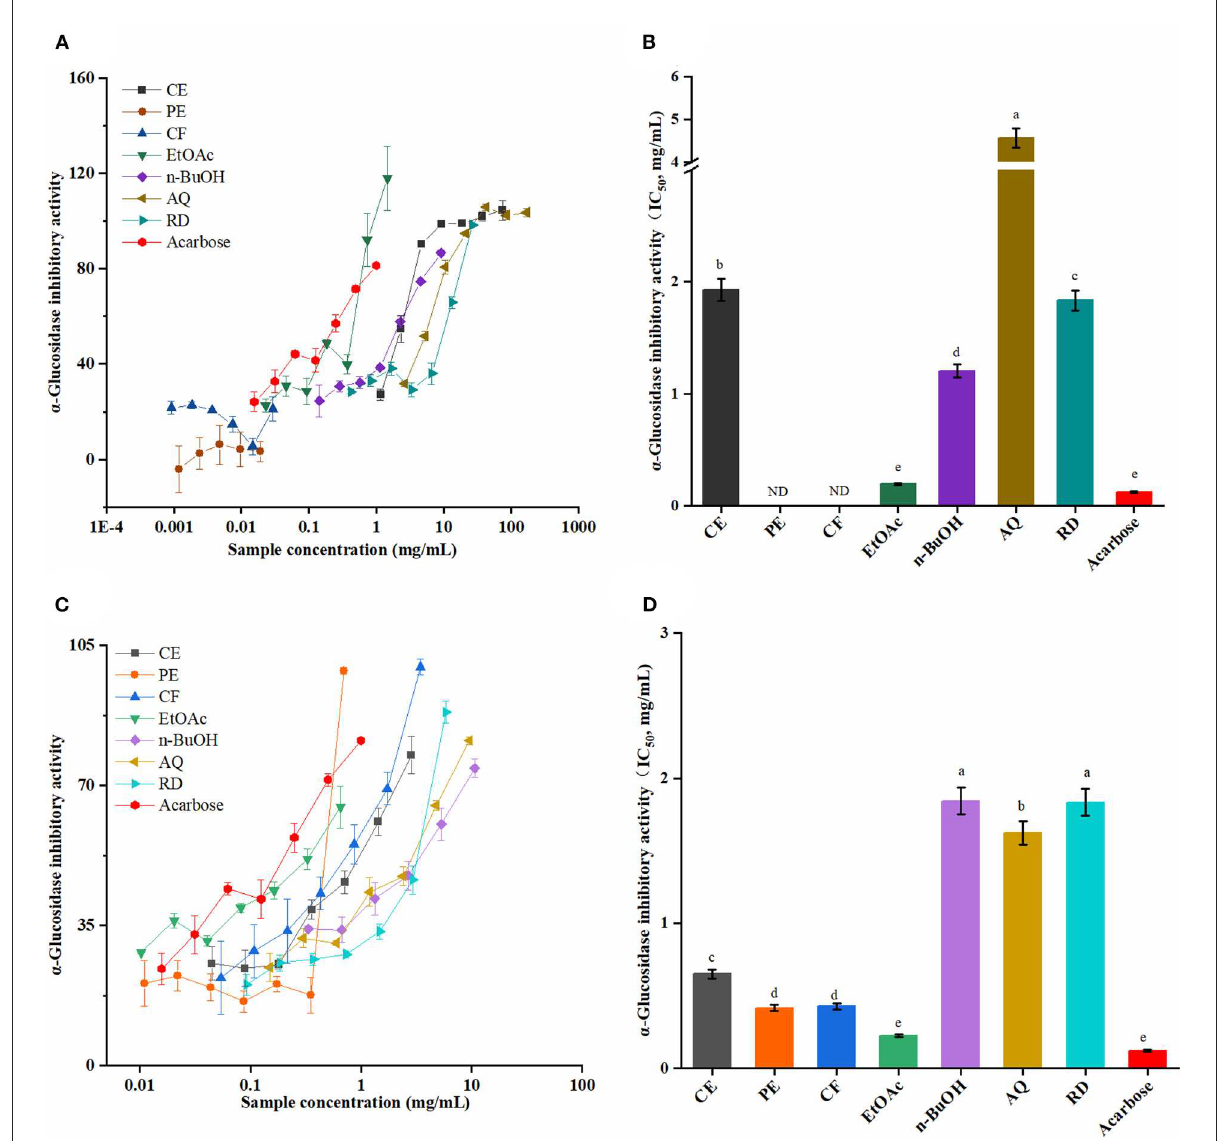
FIGURE4 The α -glucosidase inhibitory activities of the SOEs. (A,C) The inhibition ratio of α -glucosidase incubated with different concentrations of SOF and SOP; (B,D) The IC 50 values of SOF and SOP for α -glucosidase inhibition. SOEs, Stauntonia obovatifoliola extracts; SOF, Stauntonia obovatifoliola flesh; SOP, Stauntonia obovatifoliola pericarp. CE, crude extract; PE, Petroleum ether fraction; CF, chloroform fraction; EtOAc, ethyl acetate fraction; n-BuOH, n-Butanol fraction; AQ, aqueous phase residue; RD, residue; ND, not detected; IC 50 , half maximal inhibitory concentration. The superscript letters indicate the statistical difference in rows in significant, p <